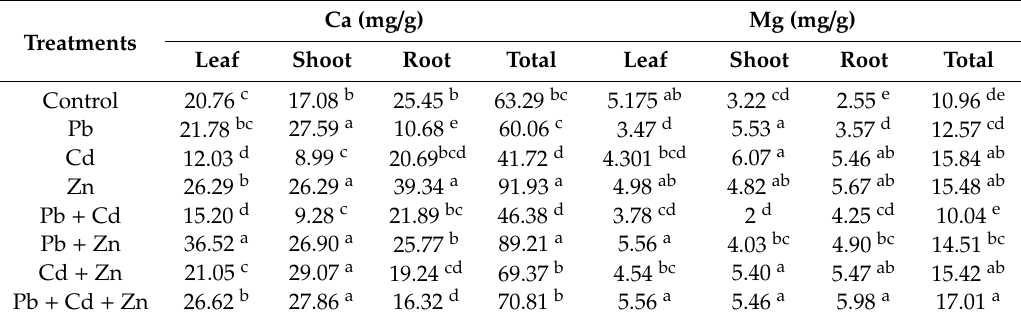
Table 2. Calcium and magnesium levels in roots, shoots, and leaves in response to Pb / Cd / Zn alone or in